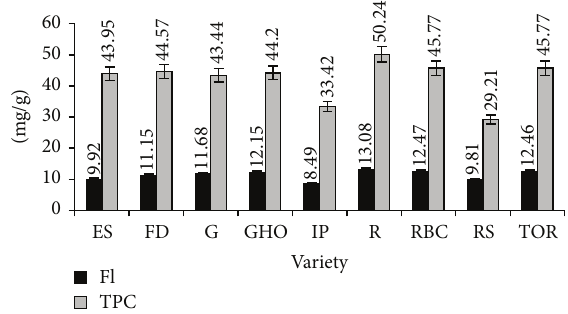
Figure 1: Total flavonoid content (black bars; Fl) and total phenolic content (grey bars; TPC) in nine varieties of C. officinalis leaves. Varieties: “Egypt Sun” (ES), “Flame Dance” (FD), “Geisha” (G), “Green Heart Orange” (GHO), “Indian Prince” (IP), “Radio” (R), “Red Black Centered” (RBC), “Russian Size” (RS), and “Touch of Red” (TOR). Under the bars—means of content, mgg −1